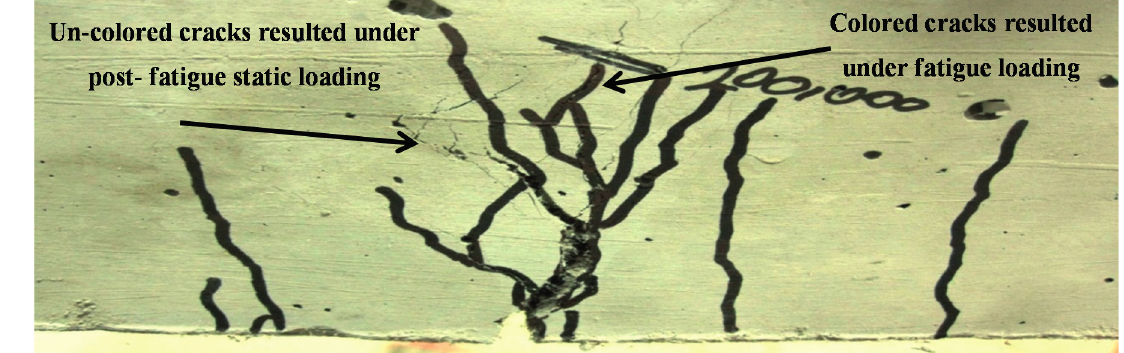
Figure 13. Multiple cracking under flexural fatigue loading.